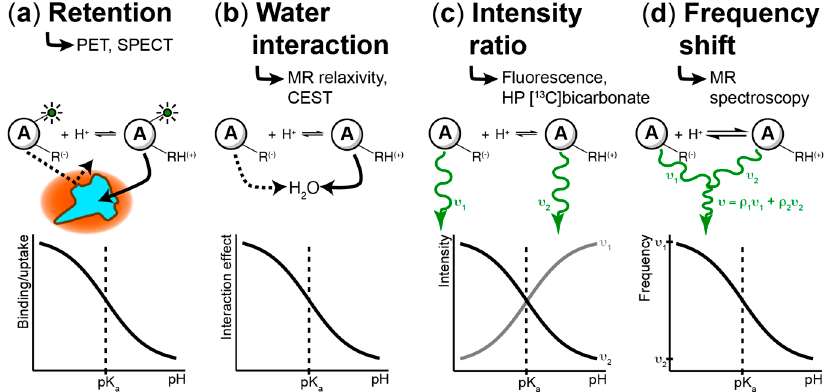
Figure 2. Mechanisms of pH measurement in cells and tissues. As a general rule, a pH-sensing agent must contain at least one functional group with a pK a within the physiological range of detection to generate image contrast. ( a ) Agents may demonstrate pH-dependent cell binding or uptake. In this case, a pH decrease can trigger a change in cell permeability, membrane binding, or release of a prodrug agent which can bind to cells. Importantly, absolute pH quantification is not possible. This approach is used primarily for pH imaging with positron emission tomography (PET) or single-photon emission computerized tomography (SPECT). ( b ) MR-based agents may interact with water protons in a pH-dependent manner, in which pH induces changes in relaxivity or in exchange (as in acido-chemical exchange saturation transfer, acidoCEST). ( c ) The protonated and deprotonated states of an agent may emit di ff erent electromagnetic frequency waves. In this case, the ratio of emission between the two wavelengths can be used to determine the pH. This approach is relevant to fluorescent-based pH probes as well as hyperpolarized (HP) [ 13 C]bicarbonate. ( d ) If the kinetic rate of protonation–deprotonation is much faster than the absolute frequency di ff erence between emission wavelengths, the agent will exhibit a frequency shift rather than two distinct emission wavelengths. The observed frequency depends on the relative populations ( ρ ) of protonated and deprotonated states, thereby giving the pH. This approach describes pH imaging with MR spectroscopic techniques ( 1 H, 31 P, HP 13 C).